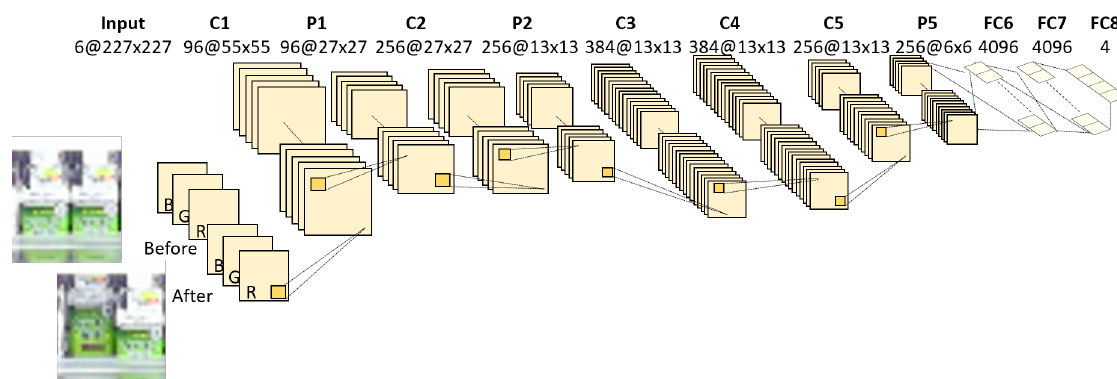
Figure 4. Network architecture based on CIFAR-10 (Canadian Institute For Advanced Research). It consists of three convolutional layers, three pooling layers and one fully-connected layer.